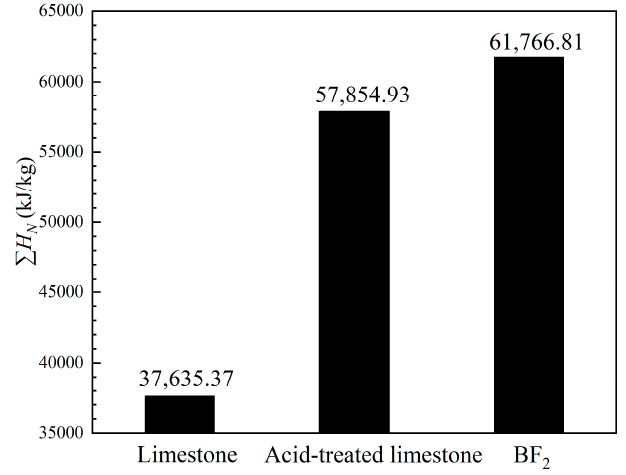
Figure 2. Cumulative energy storage density in 50 repeated cycles. Table 2. Fitting parameters for multicyclic energy storage according to Equation (3).